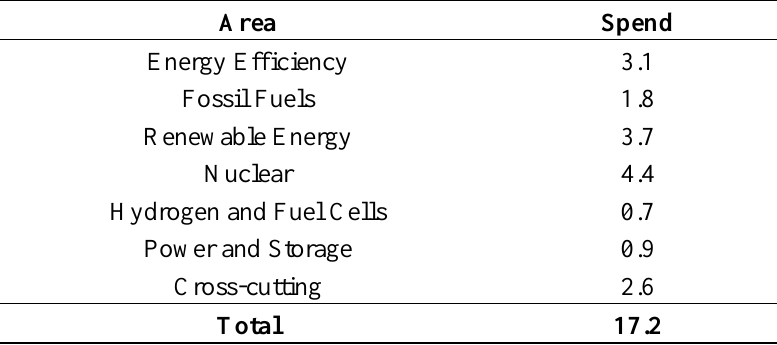
Table 2. Public sector RD&D spend in IEA countries 2011